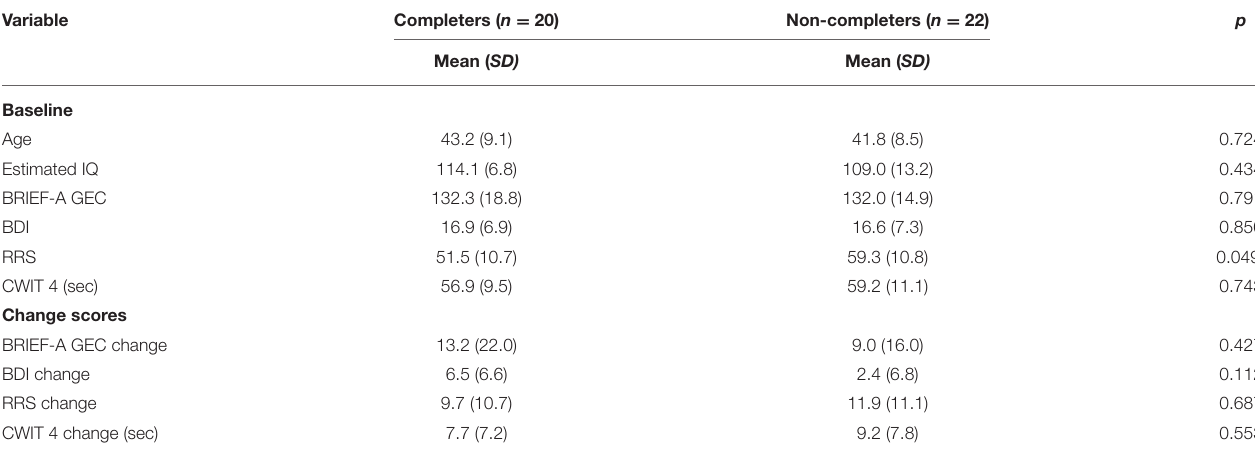
TABLE 1 | Characteristics of completers and non-completers of the 2-year follow-up.